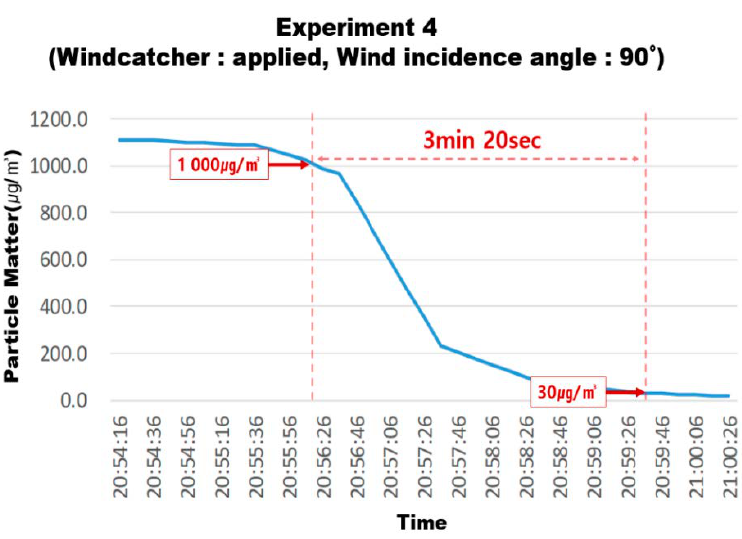
Energies 2020 , 13 , x FOR PEER REVIEW